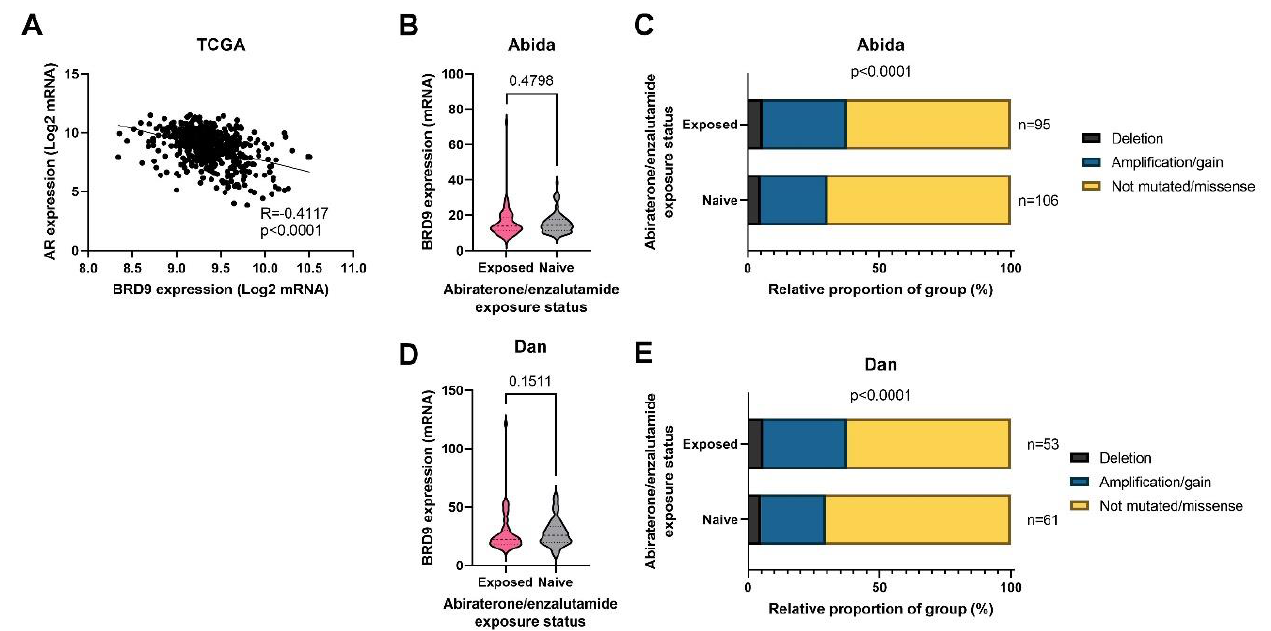
Figure 3. BRD9 as a potential drug target in CRPC in cancer omics cohorts. ( A ) Scatterplot with line of best fit showing the correlation between BRD9 and AR expression in the TCGA cohort. Spearman’s R and its associated two-tailed p -value have been calculated. ( B ) Violin plot showing BRD9 expression in who patients were and were not treated with the second generation antiandrogens abiraterone and enzalutamide in the Abida cohort. p -value was obtained using a Mann Whitney U test. ( C ) Stacked bar chart showing BRD9 mutation distribution in patients who were and were not treated with the second generation antiandrogens abiraterone and enzalutamide and the number of patients in each sample in the Abida cohort. p -value was obtained using Fisher’s exact test. ( D ) Violin plot showing BRD9 expression in who patients were and were not treated with the second generation antiandrogens abiraterone and enzalutamide in the Dan cohort. p -value was obtained using a Mann Whitney U test. ( E ) Stacked bar chart showing BRD9 mutation distribution in patients who were and were not treated with the second generation antiandrogens abiraterone and enzalutamide and the number of patients in each sample in the Dan cohort. p -value was obtained using Fisher’s exact test. Y axis scales on violin plots vary due to experimental variation.